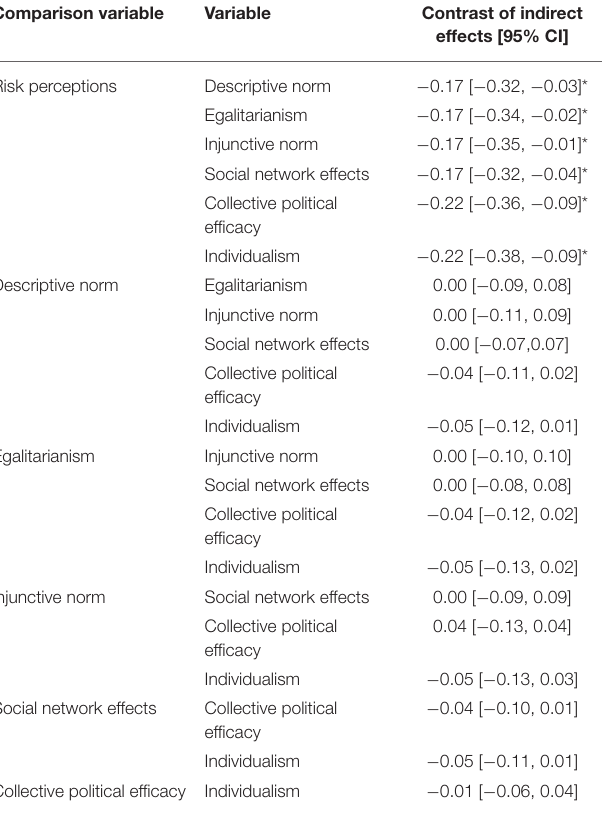
TABLE 6 | Competitive mediation analysis of having contacted a government official in the past 12 months between Latinos and Whites. Comparison variable